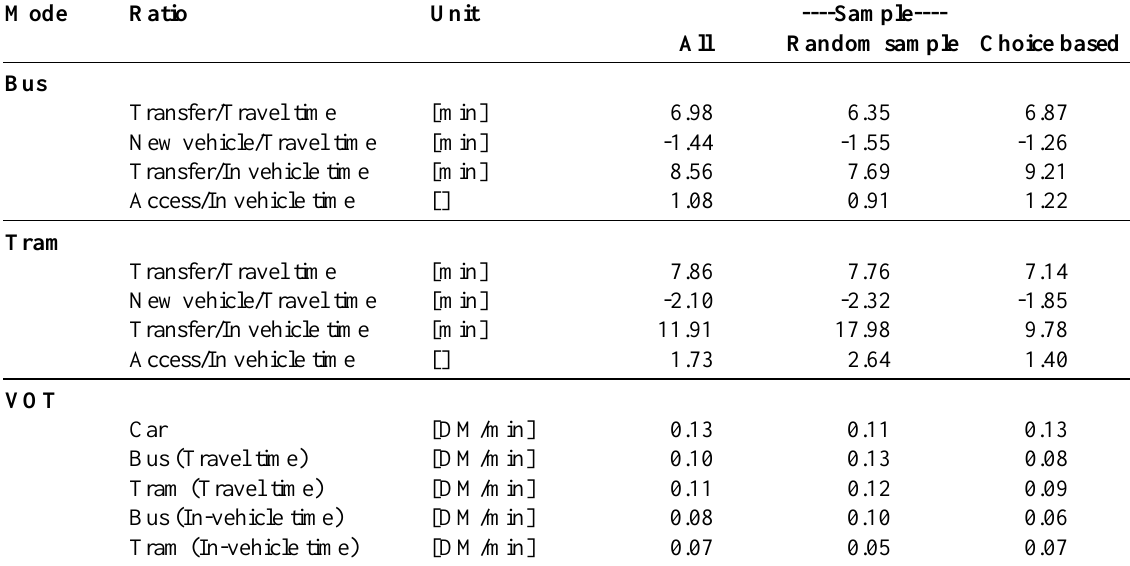
All Random sample Choice based